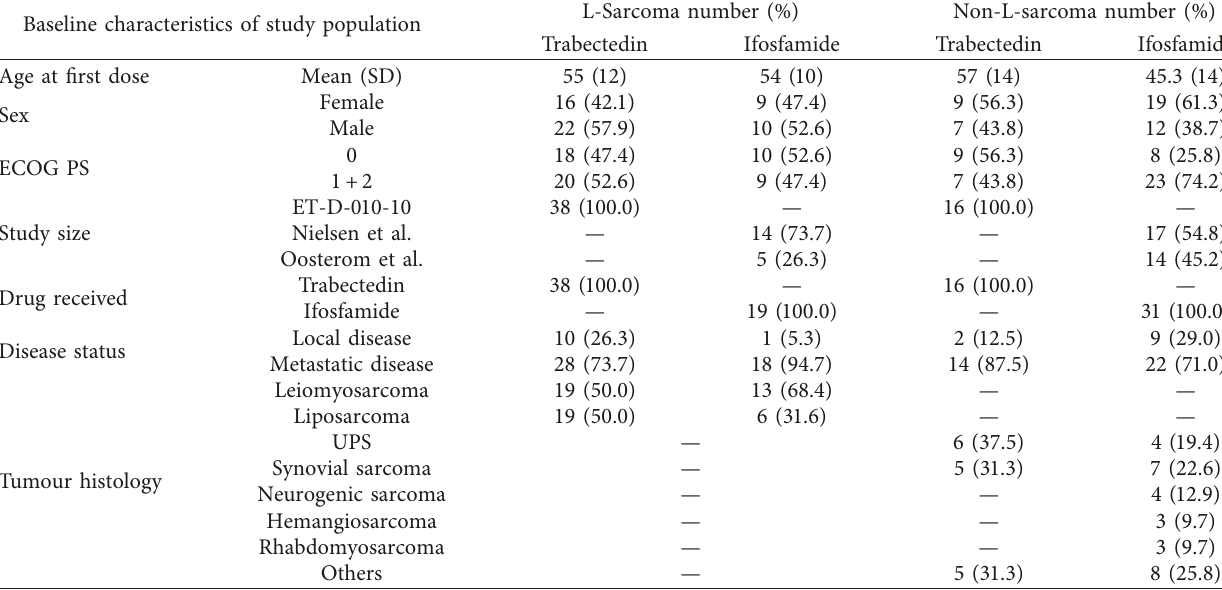
Table 1: Baseline characteristics of study population.